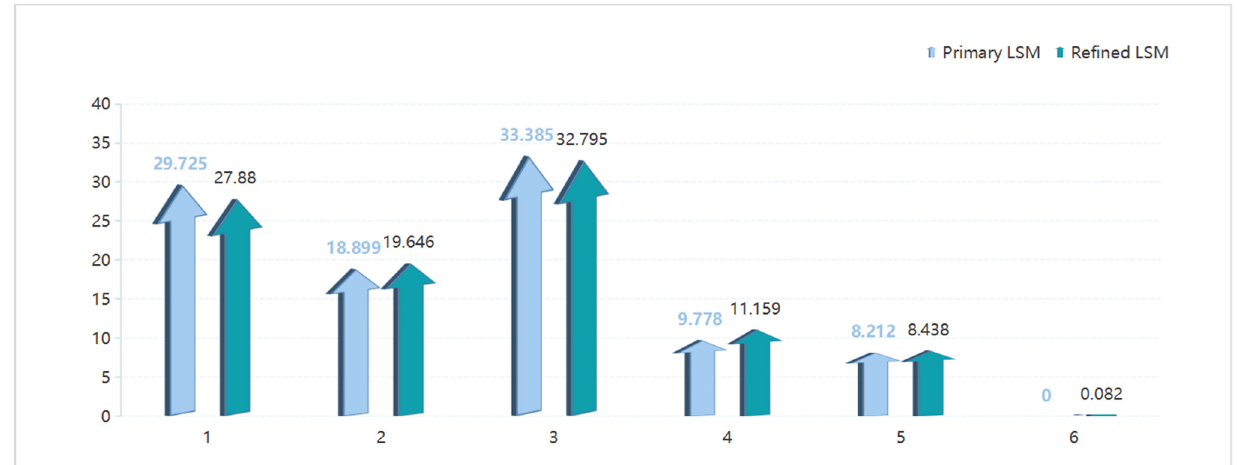
Figure 13. Distribution of susceptibility degrees of the preliminary LSM and refined LSM. The X- axis is the degree of susceptibility, and the Y-axis is the percentage of the whole area.